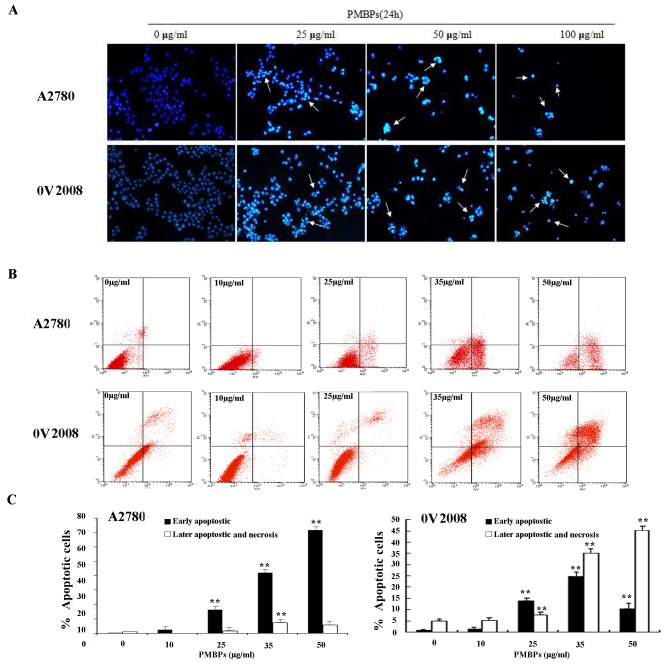
PMBPs induce apoptosis of ovarian cancer cells.(A) A2780 and OV2008 cells were treated with PMBPs (0, 25, 50, 100 μg/ml) for 24 h. The morphological changes of nuclei were examined by fluorescence microscopy using DAPI staining. The arrows indicate nuclear condensation and apoptotic bodies (magnification, 100×). (B) A2780 and OV2008 cells were treated with PMBPs (0, 10, 25, 35, 50 μg/ml) for 24 h. Flow cytometry was applied to analyze Annexin V-FITC/PI double stained A2780 cells. The low right (LR) quadrant of the histograms indicates the early apoptotic cells, and the upper right (UR) quadrant indicates the late apoptotic and necrotic cells. (C) The treatment of A2780 and OV2008 cells with PMBPs resulted in dramatic increase in the percentage of apoptotic and necrotic cells (including early apoptosis, late apoptosis and necrosis). The experiments were repeated three times. **P<0.01 compared to the control group.